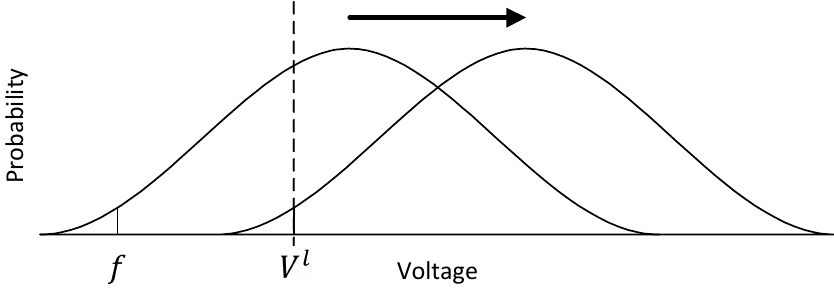
Figure 2. Illustration reducing probability of under voltages to acceptable levels.